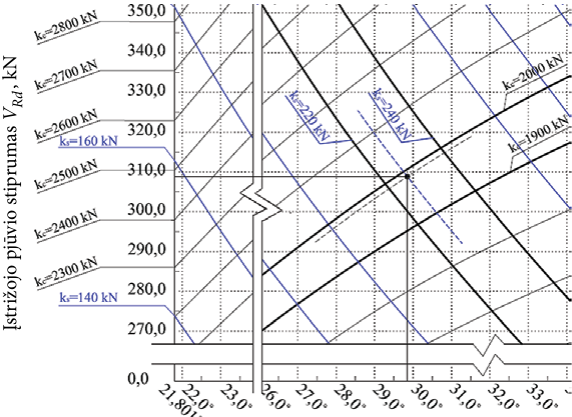
Fig. 8. The example of graphic Shear strength